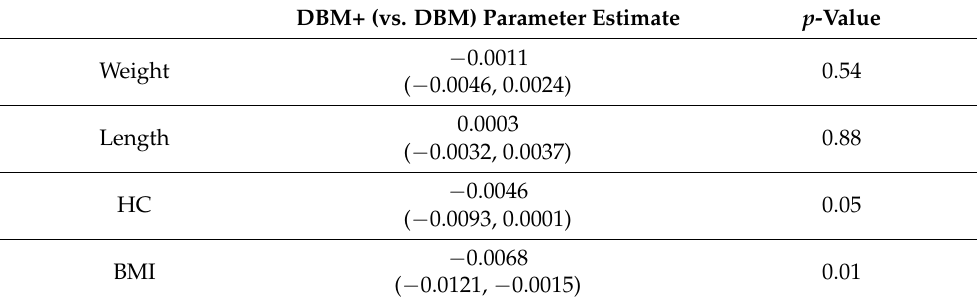
Table 9. Longitudinal analysis of z-score change over time, adjusted for SGA, with DBM cohort as reference.